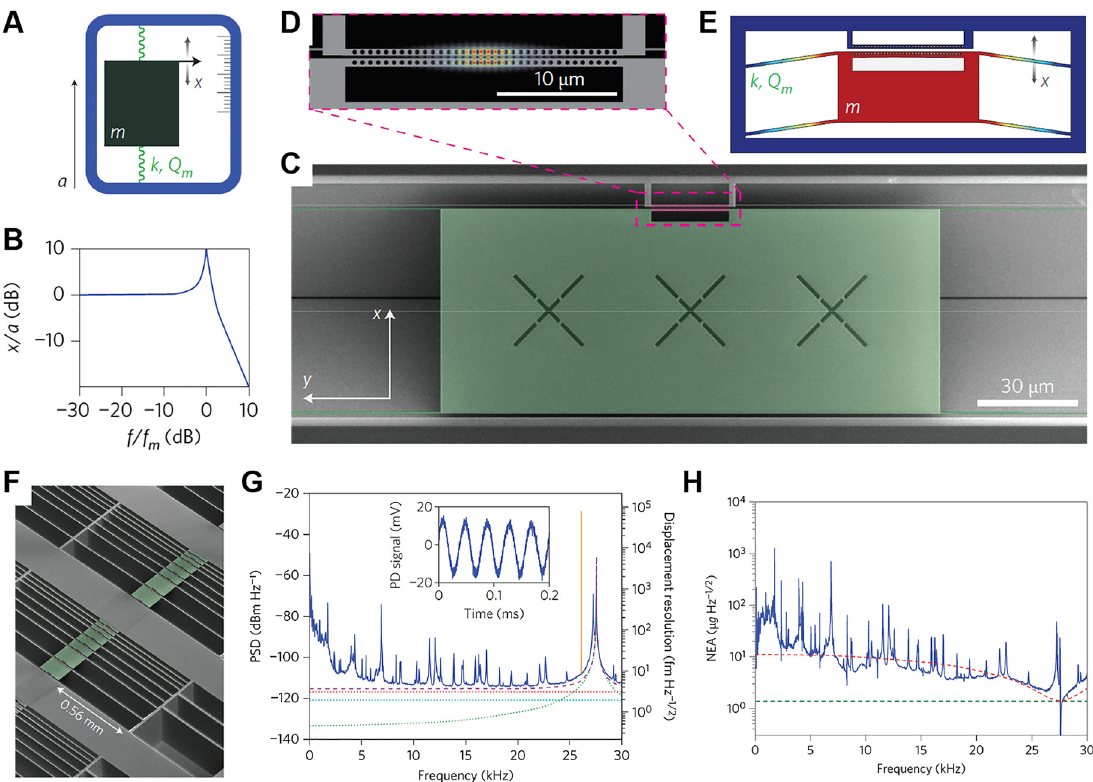
Figure 17: An on-chip optomechanical accelerometer [42]. (A) Canonical example of an accelerometer. When the device experiences a constant acceleration a , a test mass m undergoes a displacement x = ma ∕ k , in which k is the spring constant of the mechanical resonator. √ = (B) Frequency response 𝜒 ( 𝜔 ) of an accelerometer in an log–log plot, showing a mechanical resonance at frequency f k ∕ m ∕ 2 𝜋 with m = 10. (C) False-colored SEM image of the optomechancial accelerometer. (D) Zoom in of the zipper photonic mechanical quality factor Q m crystal nanocavity, showing the electric field | E ( r ) | of the fundamental bounded mode of the zipper cavity. The top beam is mechnically anchored to the bulk SiN and the bottom beam is attached to the test mass. (E) Schematic displacement profile of the fundamentalin-plane mechanical mode used for acceleration sensing. (F) SEM image of an array of devices with different test mass sizes. (G) Left axis: optical power spectral density of the balanced photodetector signal showing mechanical modes at 27.5 kHz. Right axis: equivalent displacement noise. The tone at 26 kHz is transduction of the acceleration signal applied to the shear piezo corresponding to an acceleration of 38.9 mg. The dashed and dotted lines are theoretical noise levels for shot noise (red), detector noise (cyan), thermal noise (green), and the total noise (purple). Inset: time trace of the transduction of an applied acceleration of 35.6 mg at 25 kHz. (H) Frequency-dependent noise equivalent acceleration (NEA) of the device, quantifying its broadband